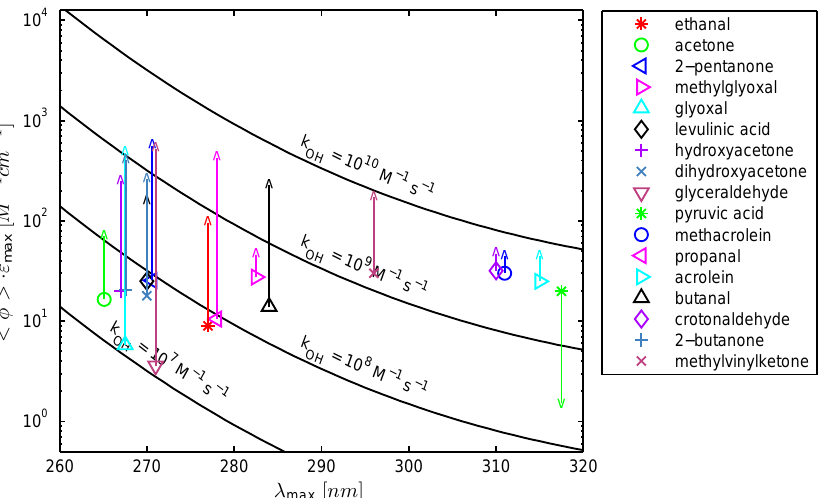
Fig. 5. Comparison of aqueous photolysis at a solar zenith angle of 20 ◦ and aqueous oxidation by OH at a typical daytime concentration of 10 − 13 M and a pH of 2. Molecules, denoted by the markers in the key, have arrows that point to their corresponding k OH . k OH isopleths correspond to λ max and ε max · < 8 > values, which produce Q = 1. Molecules with values of λ max and ε max · < 8 > that are below their corresponding k OH value will be preferentially removed with oxidation by OH (all of the molecules in this figure except for pyruvic acid). Conversely, molecules with values of λ max and ε max · < 8> that are above their corresponding k OH value will be preferentially removed by aqueous photolysis. Similar to Fig. 4, the 425 nm band of methylglyoxal and the 425, 440, and 455 bands of glyoxal will potentially allow for photolysis lifetimes that are shorter than the values represented in the figure if it contributes to aqueous